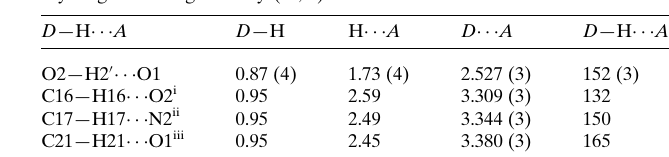
Table 1 Hydrogen-bond geometry (A˚ , (cid:2) ).